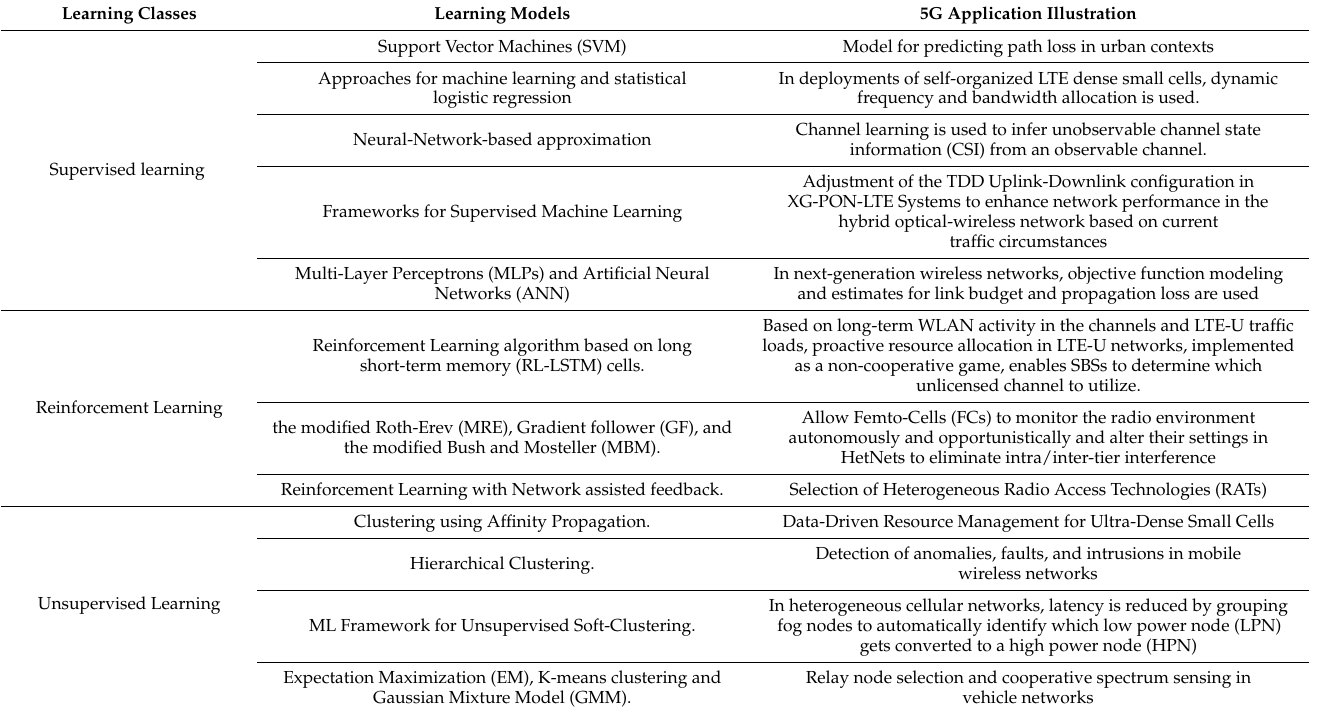
Table 6. Some Learning Methods and their Applications in 5G for the Three Types of Machine Learning. Learning Classes Learning Models 5G Application